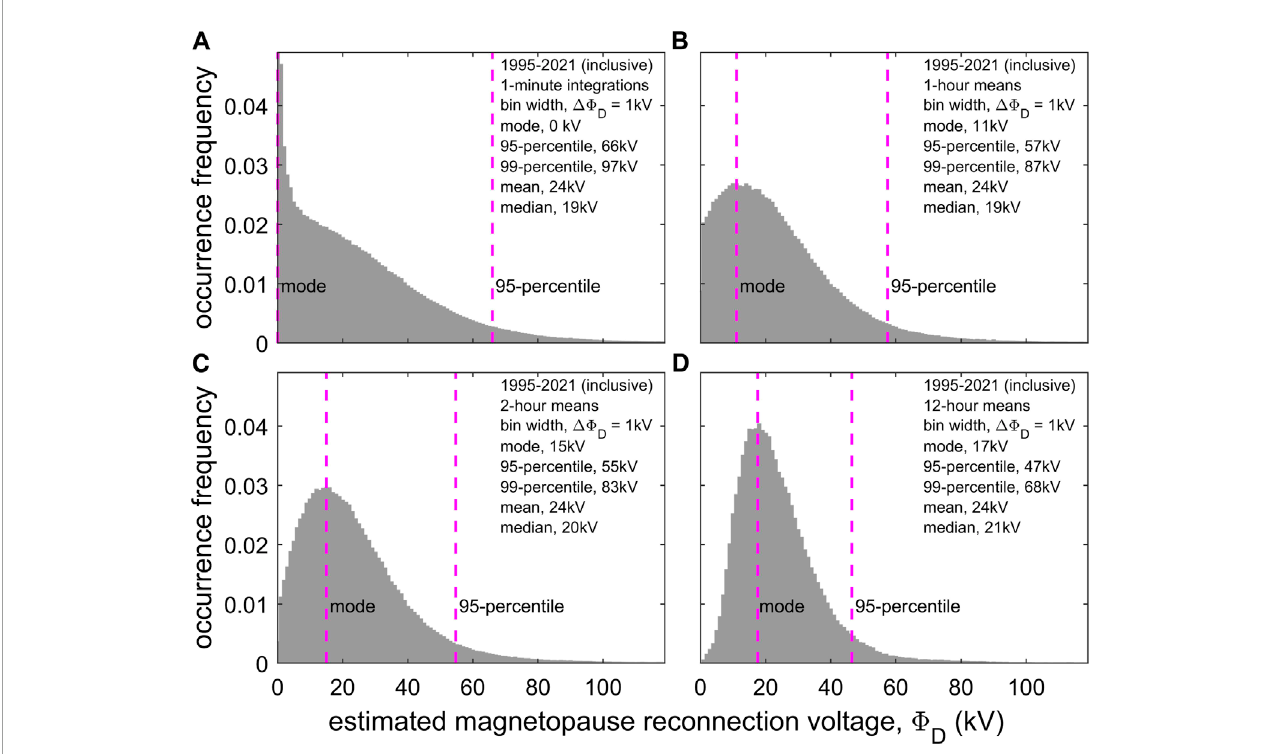
FIGURE 4 Distributions for different averaging intervals of estimates of the dayside reconnection voltage Φ D from upstream interplanetary measurements, using the optimum coupling function for transpolar voltage derived by Lockwood and McWilliams (2021a). (A) 1-min raw data; (B) . 1-h averages; (C) . 2- averages; (D) 12-h averages. The mean value of these distribution is 24 kV and in each case the mode, the median and the 95- and 99-percentiles are given.